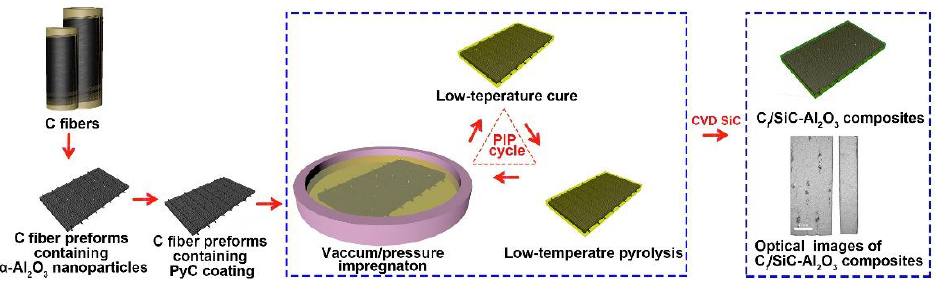
Figure 1. Schematic diagram of unidirectional, laminated T800 carbon fibers preforms.